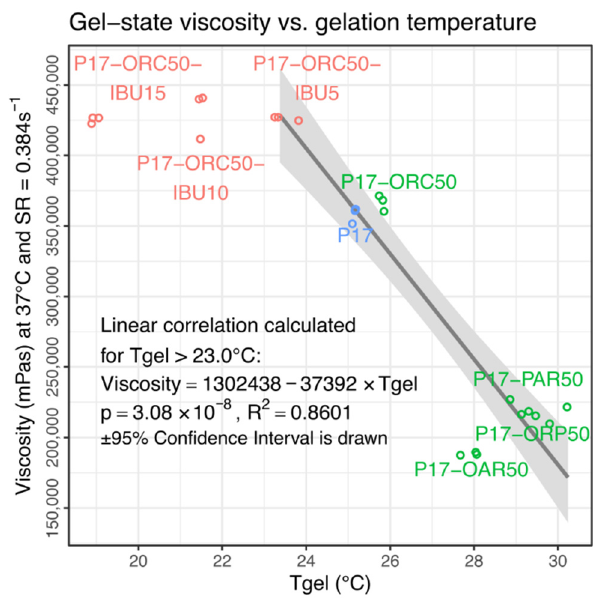
Figure 9. An overview of gel viscosities vs. corresponding Tgel values. A negative, linear correlation between viscosities measured at 37 °C and Tgel is observed in formulations less prone to gelation.